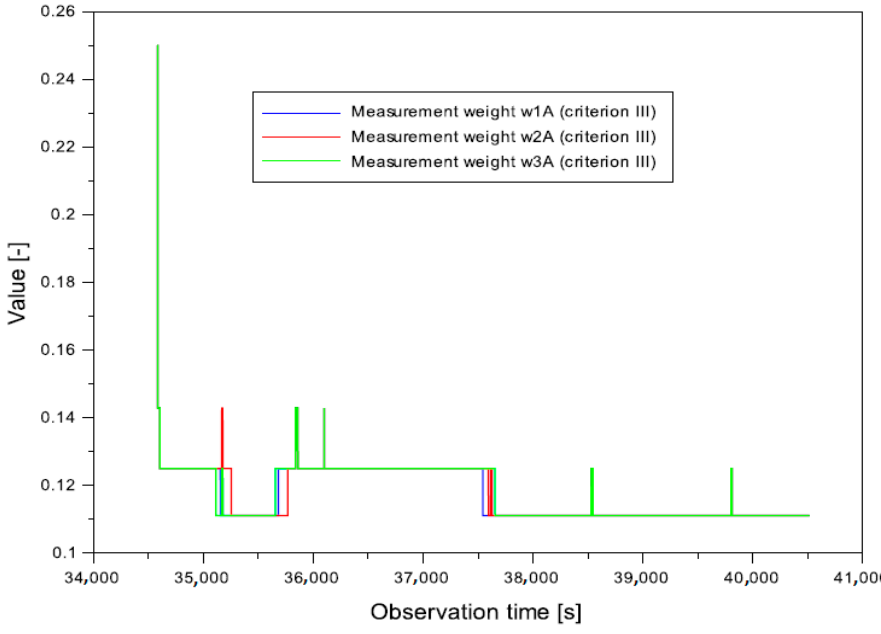
Figure 8. The measurement weights for criterion III.